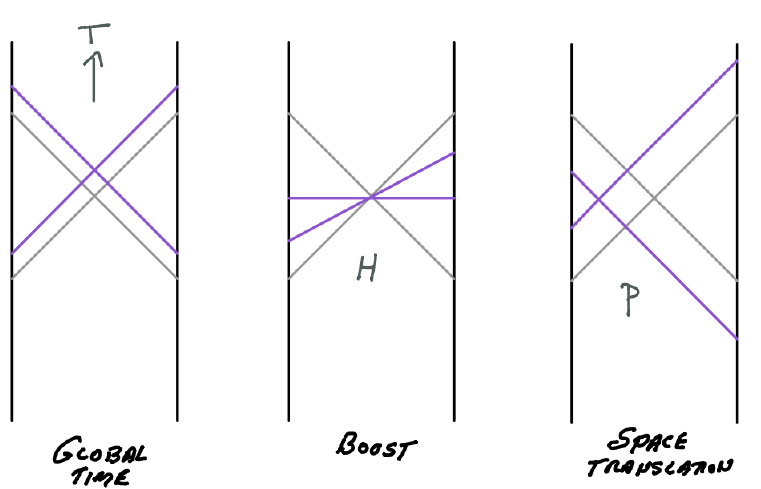
generates global time translations and vertically shifts T generates space-like P